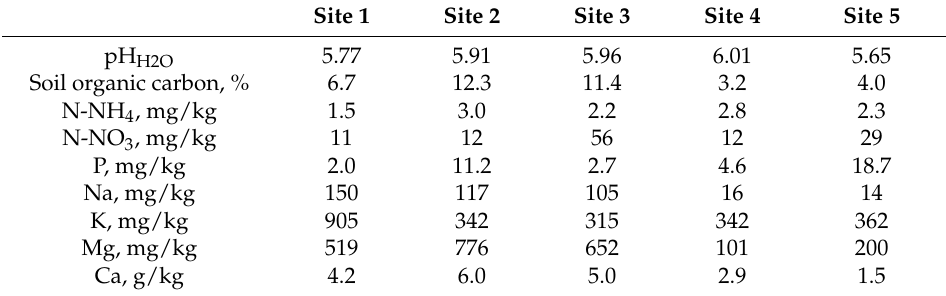
Table 2. The soil chemical properties at different sites before the start of the microplot field